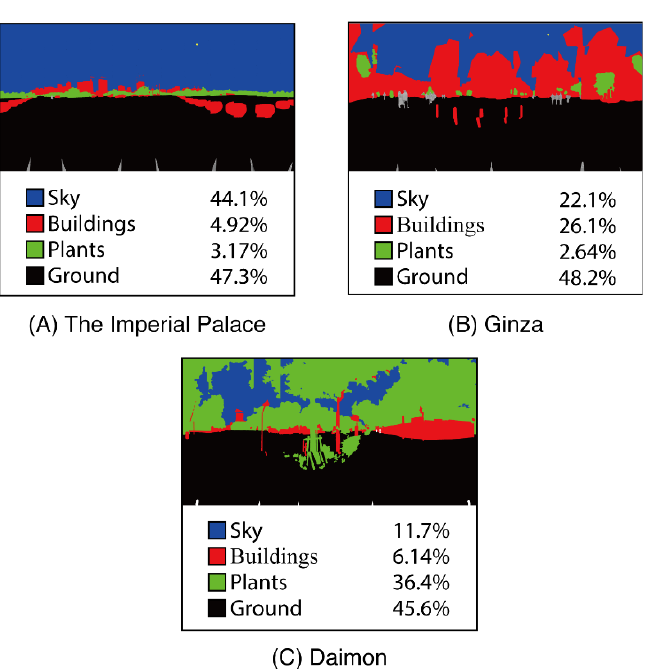
Figure 9. Structure classification at each location: ( A ) the Imperial Palace, ( B ) Ginza, and ( C ) Daimon.